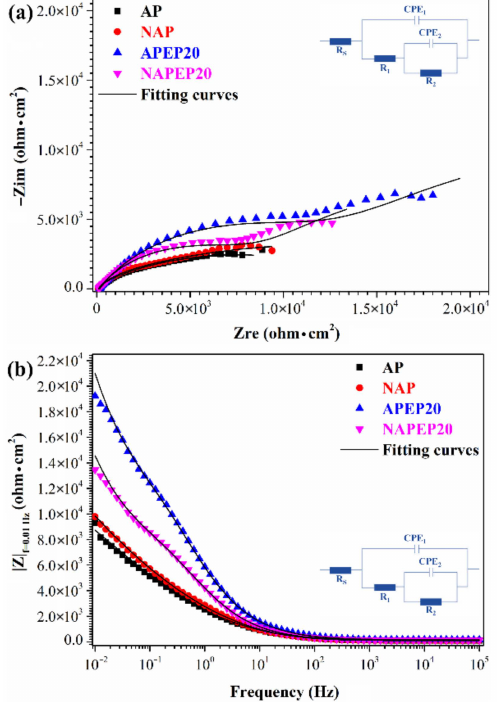
Figure 11. The ( a ) Niquest and ( b ) Bode results for the NAP, AP, NAPEP20 and APEP20 samples in 3.5 wt.% NaCl